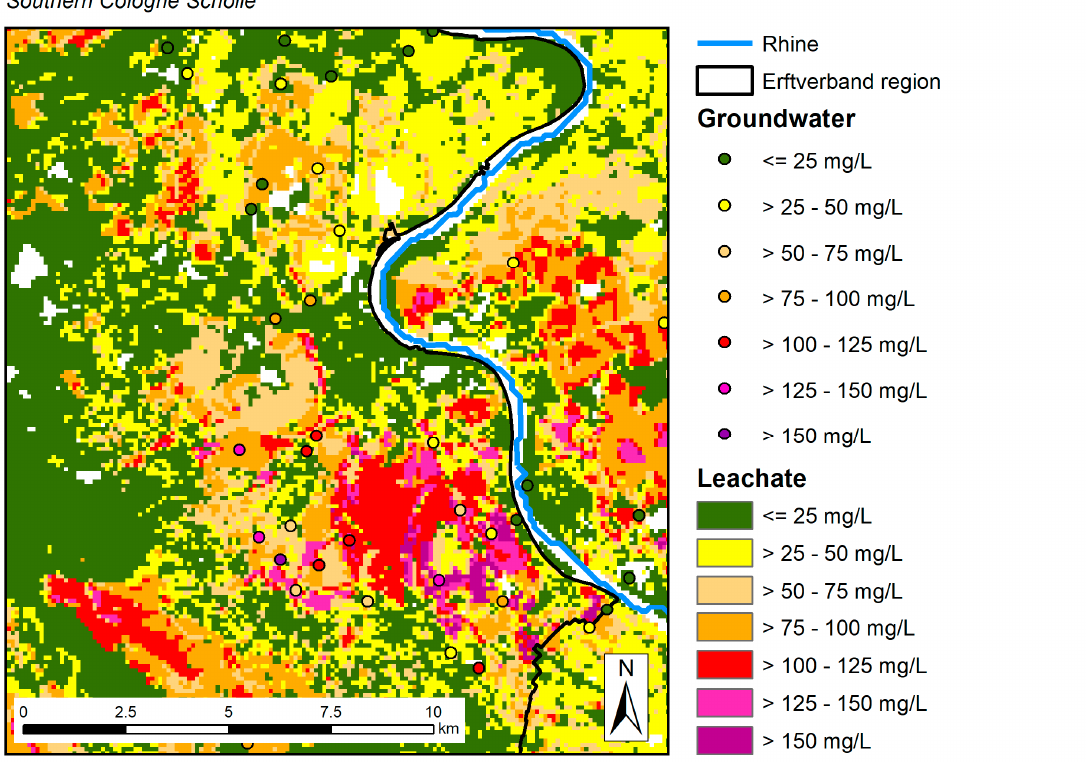
Figure 11. Comparison of the modelled nitrate concentration in the leachate (grids) with measured nitrate concentrations in groundwater (dots) for an area south of Cologne.